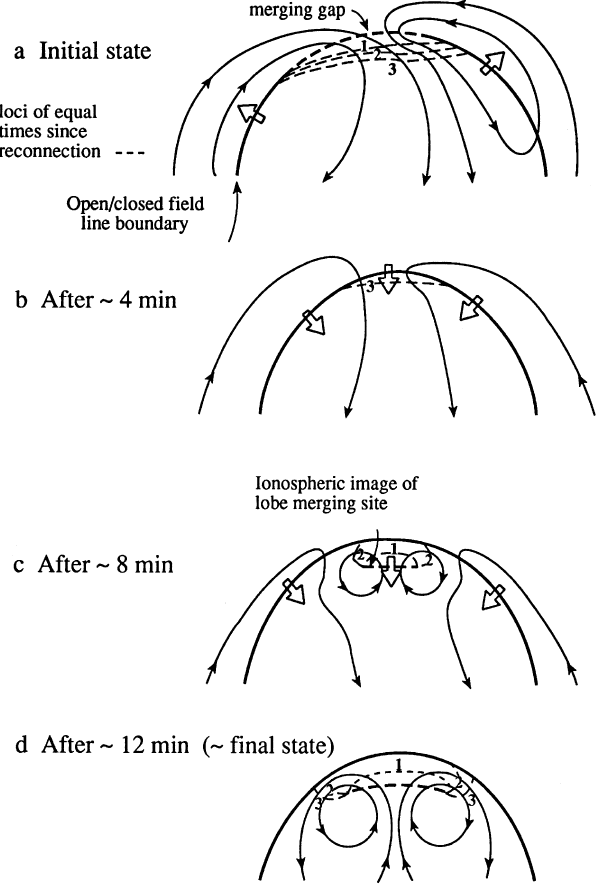
Fig. 3a–d. Sketches illustrating the expected evolution of flow in the dayside high-latitude ionosphere consequent on a change in the direction of the IMF from negative B and positive B to positive B z y z and near-zero B , taken from Fig. 7 of Øieroset et al. (1997). Arrowed y solid lines are plasma streamlines, heavy solid lines are the adiaroic segments of the open-closed field line boundary, and heavy dashed lines map along the field to magnetopause reconnection sites. The numbered dashed lines indicate lines of equal time since reconnection downstream from the latter, indicating the fall of the lower cut-o(cid:128) energy of cusp ions as this time increases. The large arrows indicate the direction of boundary propagation